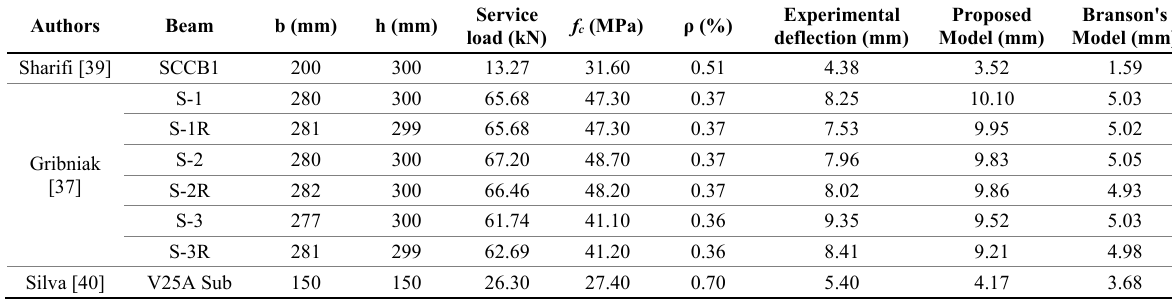
Table A1. Beams data with f c from 20MPa to 50MPa and reinforcement rate from 0 a 1%.